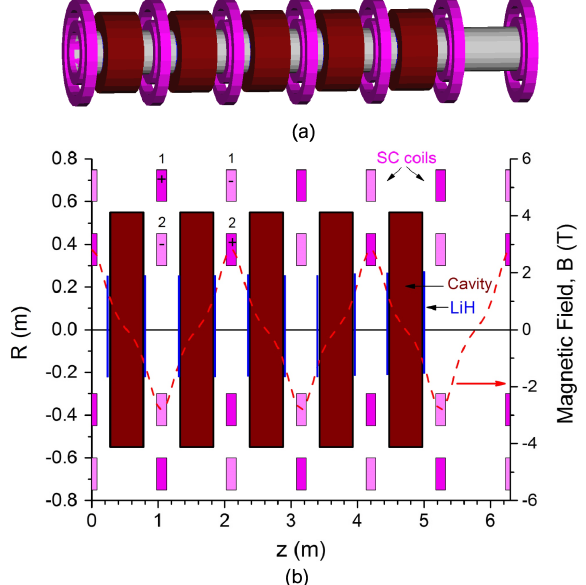
FIG. 2. Schematic representation of the RBC lattice: (a) Con- figuration in 3D; (b) side view. Note that six cells are shown. The magenta cylinders are solenoids, the red cylinders are the active volume of the rf cavities, and the blue blocks are LiH absorbers. The dashed red line shows the magnetic field along the axis. The current densities for coils 1 and 2 are 90 and 120 A = mm 2 , respectively.